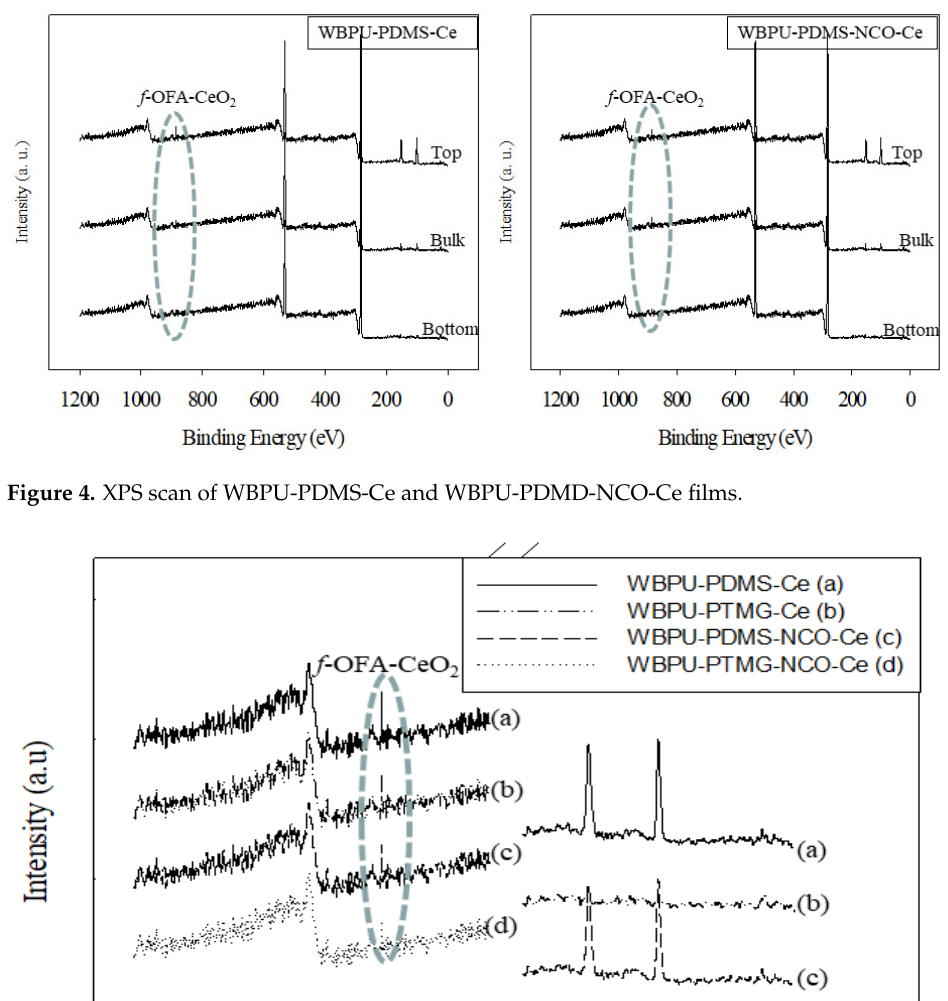
Figure 3. XPS scan of WBPU-PTMG-Ce and WBPU-PTMG-NCO-Ce films.